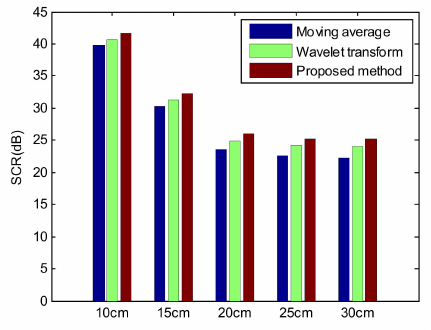
Figure 11. SCR at various burial depths and for different clutter suppression